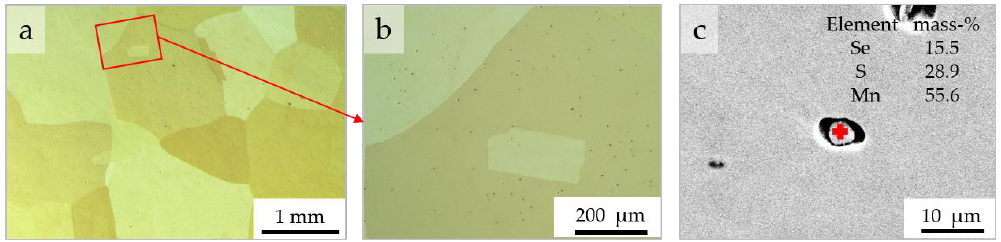
Figure 1. Microstructure after brine quenching from 1150 °C; ( a , b ) optical micrographs; ( c ) SEM micrograph of an inclusion and its SEM-EDS analysis result.